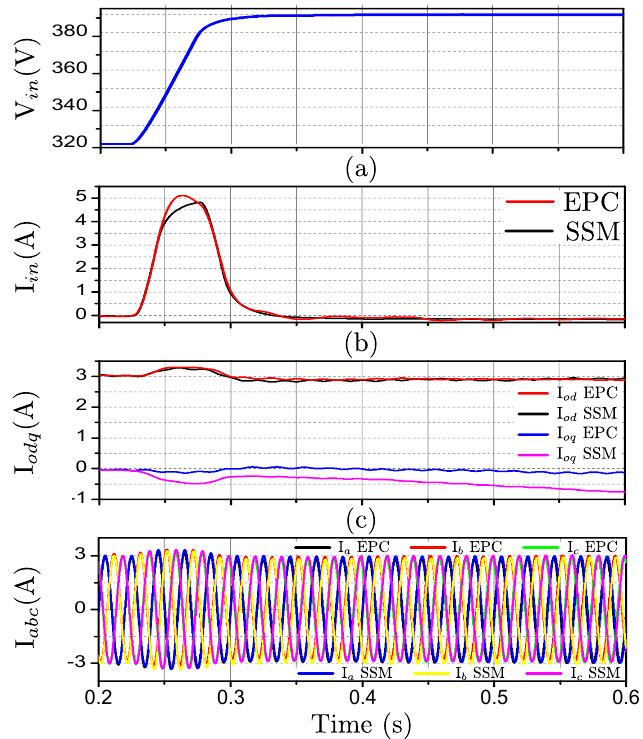
Figure 10. Comparison between ( a ) I in , ( b ) I odq and ( c ) I abc of the EPC and the small-signal model (SSM) for a step in V in of 60